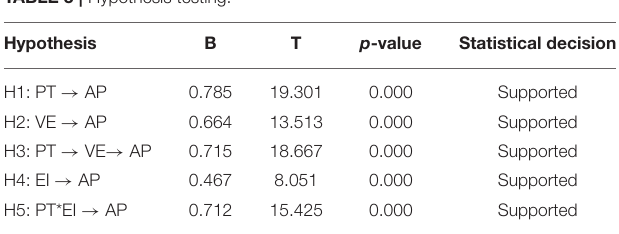
TABLE 3 | Hypothesis